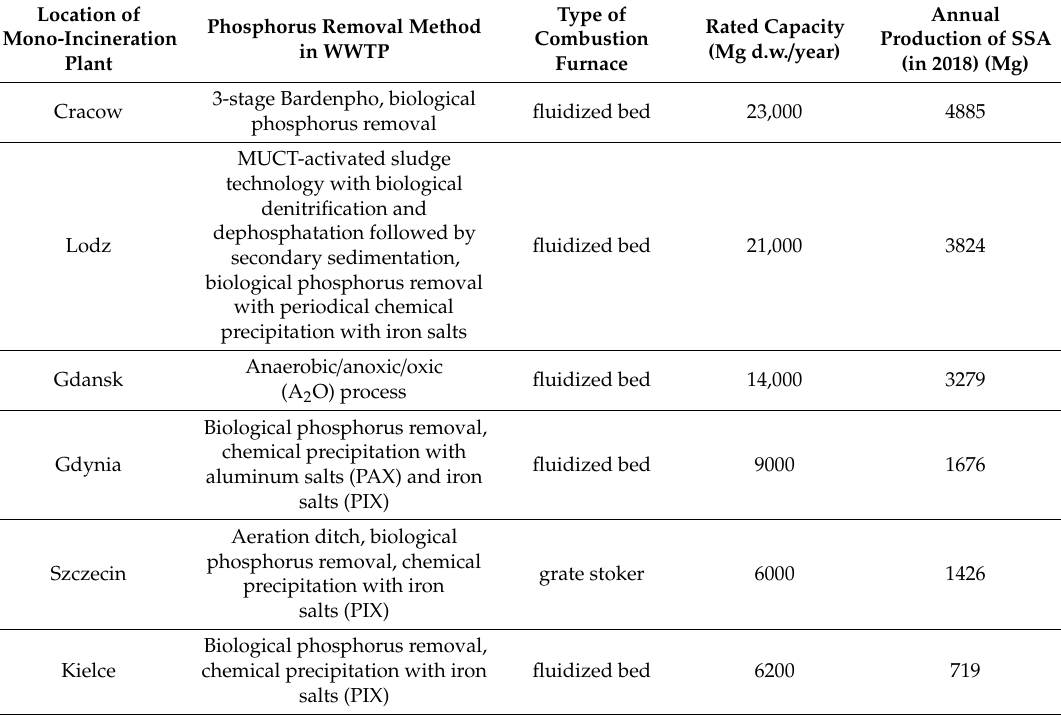
Table 1. Basic information about the analyzed Polish mono-incineration plants